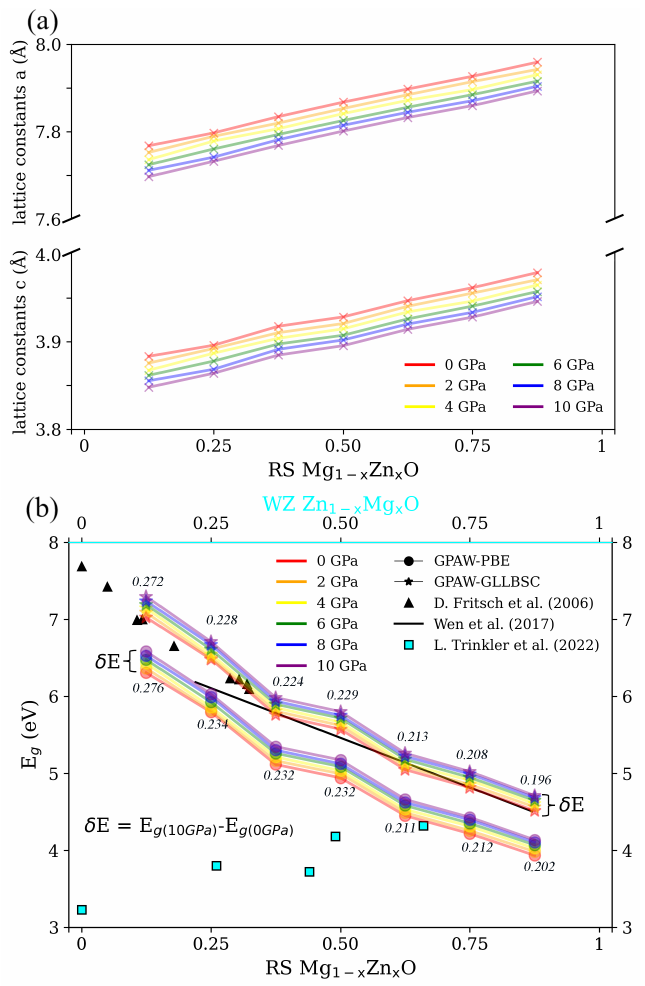
Figure 2. ( a ) The lattice constants and ( b ) band gap ( E g ) of rocksalt (RS) Mg 1 − x Zn x O for x = 0.125, 0.25, 0.375, 0.5, 0.625, 0.75 and 0.875 as well as the pressures ranging from 0 to 10 GPa. Subfigure ( a ) presents the lattice constants of the a (upper) and c (bottom) axes. In Subfigure ( b ), the black triangles and cyan squares are the experimental E g of the RS ZMO alloys [48] and WZ ZMO epilayers [4], respectively. The black line is the fitted result of E g ranging from x = 0.22 to 0.87 according to PBE and GLLBSC functionals, respectively. The colors red, orange, yellow, green, blue and purple correspond to 0, 2, 4, 6, 8 and 10 GPa. The difference in the theoretical E g ( δ E) between 10 and 0 GPa is marked. The top label of cyan color corresponds to the expression of wurtzite (WZ) Zn 1 − x Mg x for the experimental concentration in Subfigure ( b ). The detailed E g in Appendix A of Table A1 corresponds to the values in Subfigure ( b